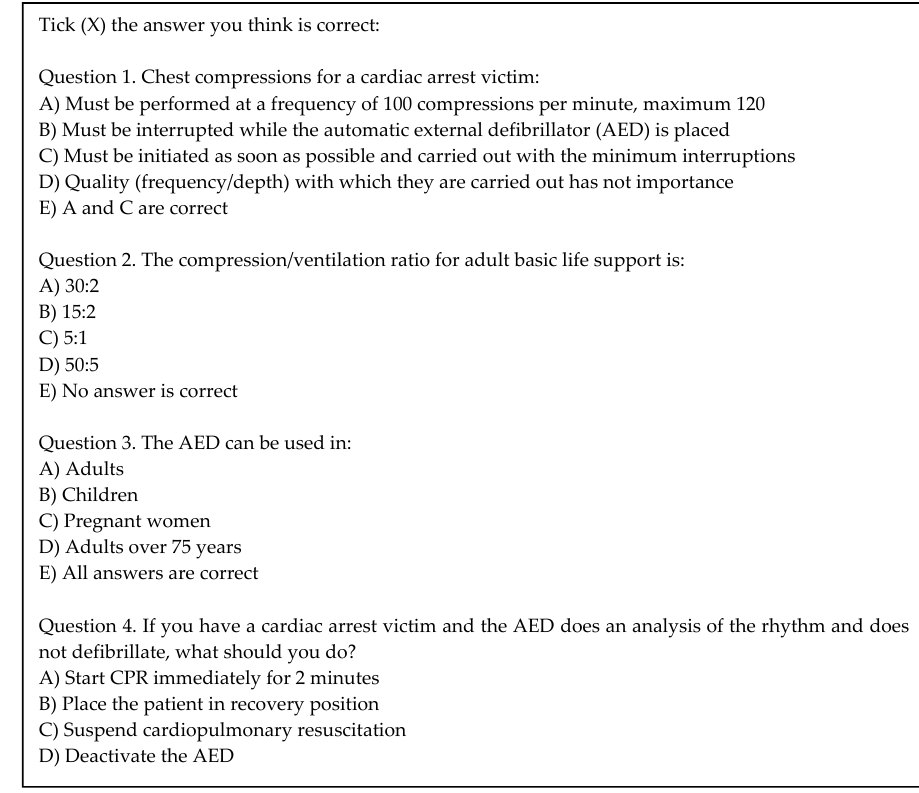
Figure 1. Questionnaire for assessing the knowledge in basic CPR and AED use.